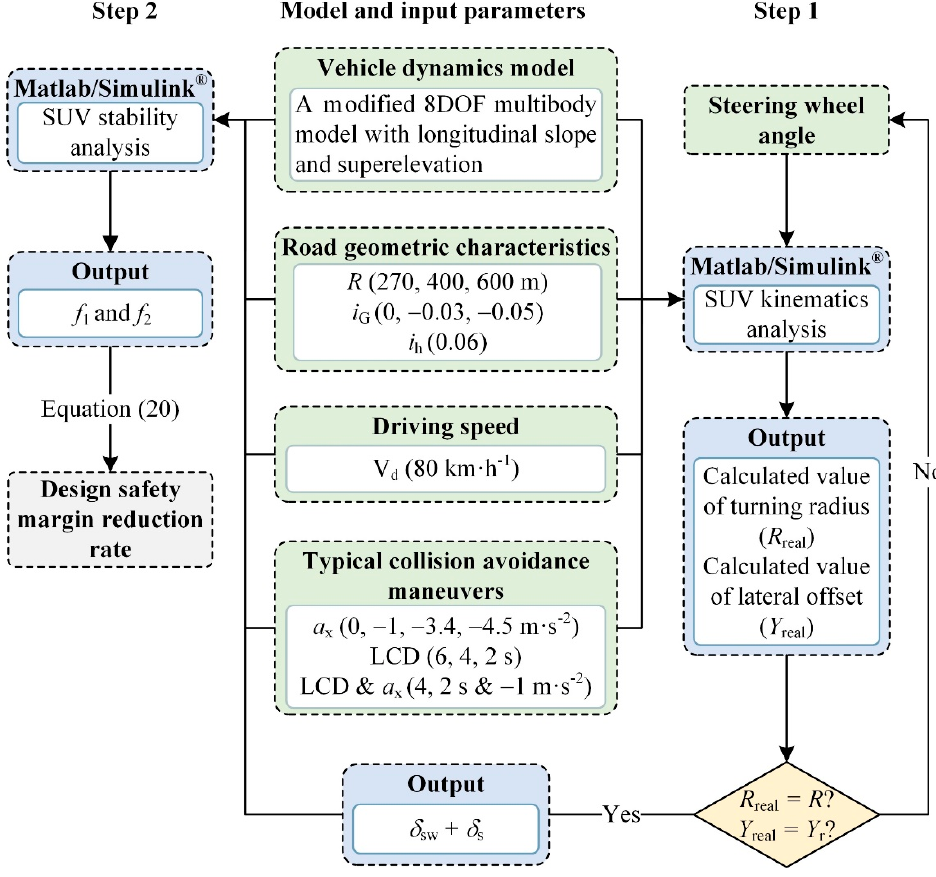
Figure 3. Calculation process for the steering wheel angle and design safety margin reduction rate.